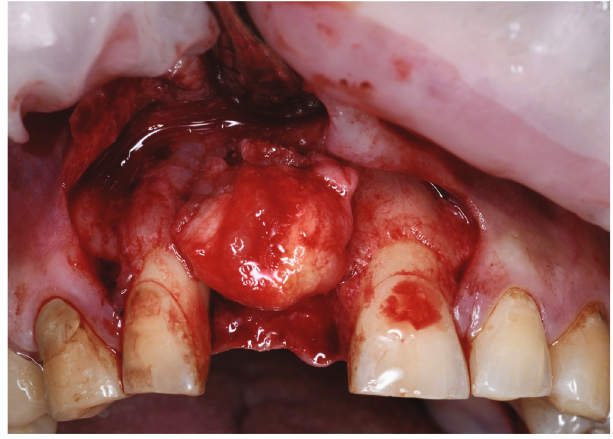
Figure 9: The block securely positioned into the